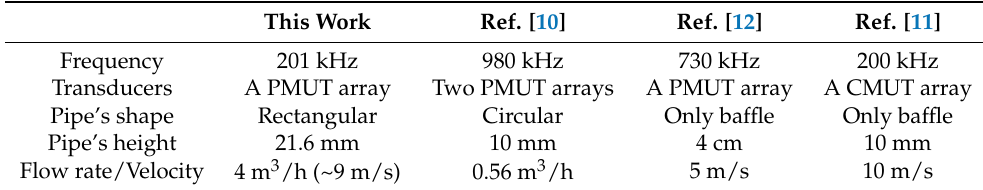
Table 3. Comparison of reported MUT for airflow